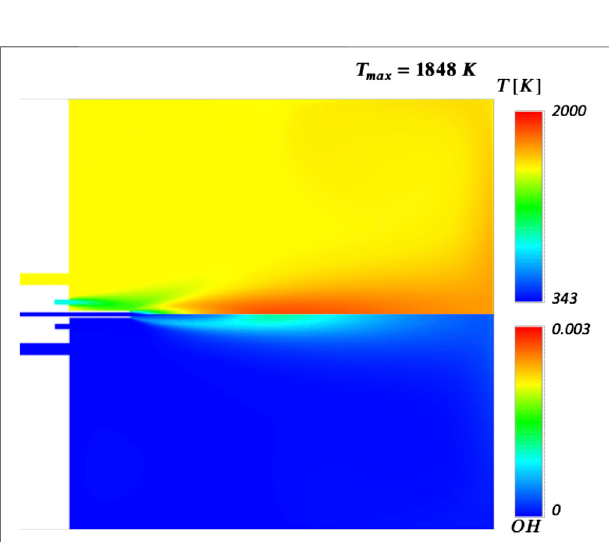
FIGURE10| Case12(70%H 2 )temperaturecontour.Theincreasedfuel nozzle length has the effect of reducing the maximum temperature by approximately 150